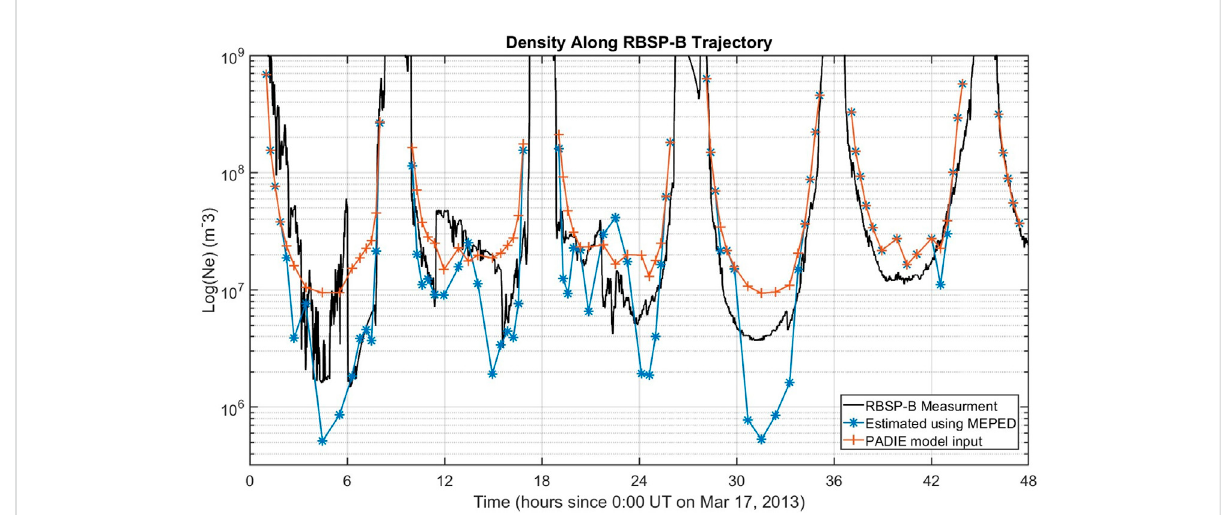
FIGURE 8 Comparison of estimated densities to Van Allen Probes measurements. The densities measured by the RBSP-B spacecraft are shown in (black), for time periods where the spacecraft was in the radiation belts (L ≥ 3). The densities estimated using the MEPED scaling method in Section 4.2 are shown in the (blue) curve, with reasonable agreement to RBSP-B. However, much of this agreement with observations is due to the high quality of the statistical density model used in the PADIE code (orange).